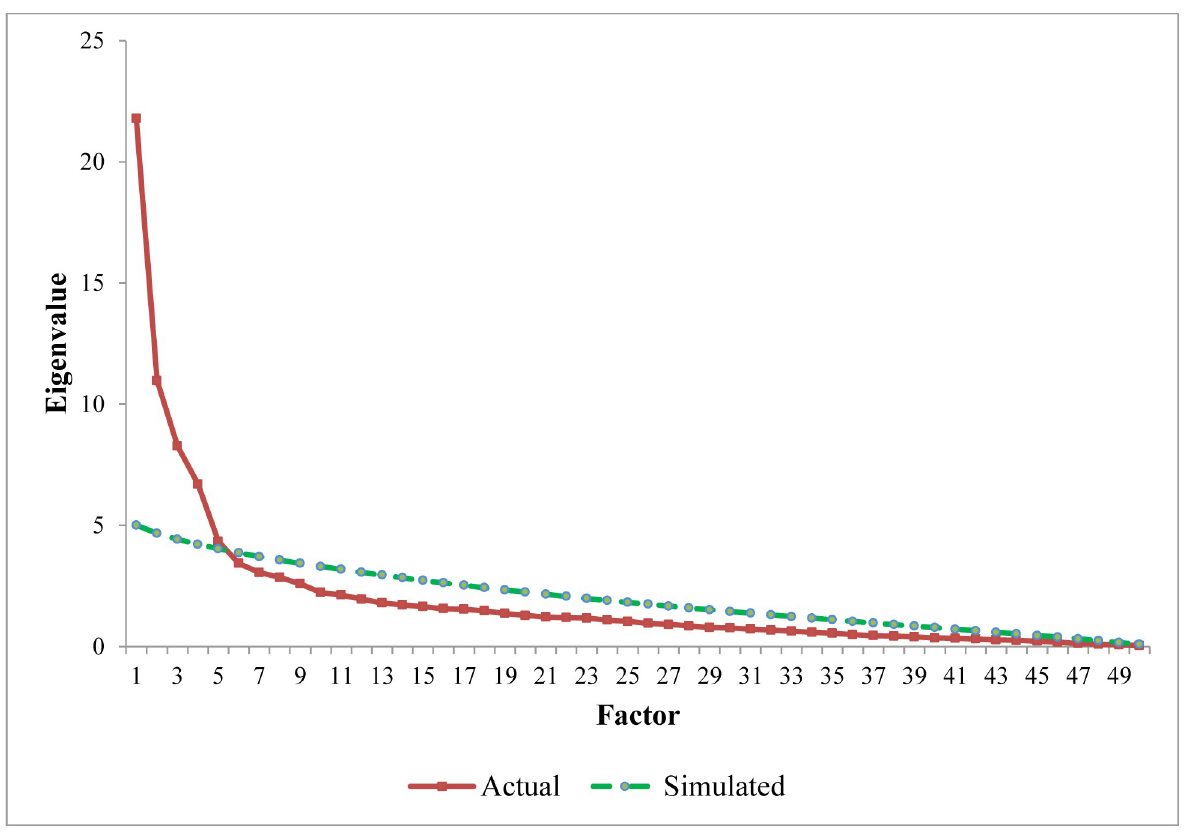
Fig 2. Parallel analysis scree